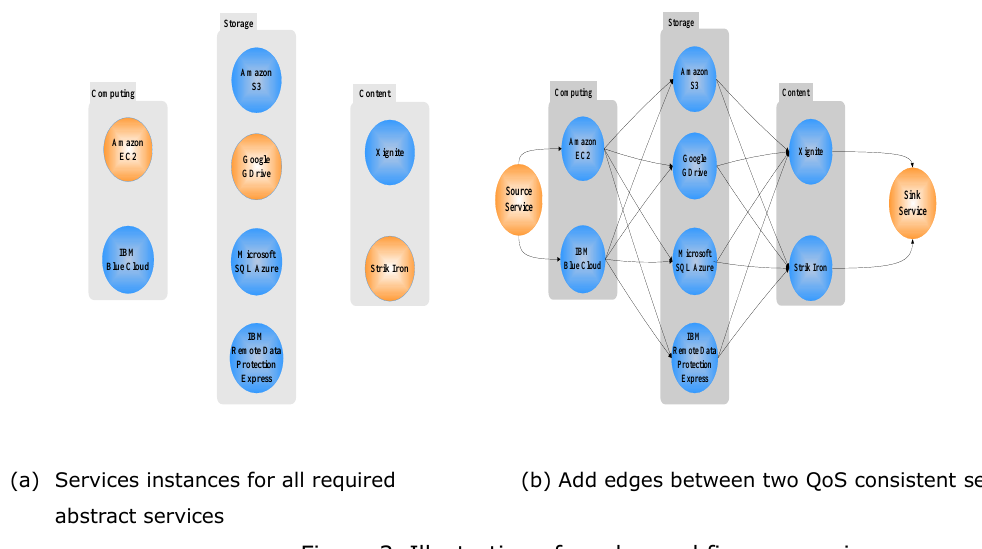
Figure 3. Illustration of on-demand finance